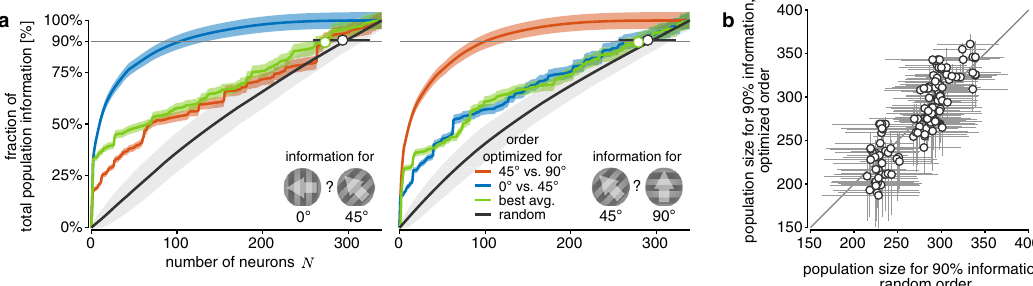
Fig. 5 No single neural subpopulation appears to encode a disproportionate amount of information across all stimulus drift directions. a Both panels show that the information increase in the recorded population depends on the order with which neurons are added to the population (colors). The panels differ in the considered drift direction discrimination (left: 0° vs. 45°; right: 45° vs. 90°). The neuron order was optimized by incrementally adding the neuron that resulted in the largest information increase for a 0° vs. 45° (blue) or 45° vs. 90° (orange) drift direction discrimination, or largest average increase across all discriminations with δθ = 45 ° (green). The optimal ordering for the 0° vs. 45° was also applied to the 45° vs. 90° discrimination (blue line in right panel) and vice versa (orange line in left panel). The average information increase across random orders (black) is shown as baseline reference. Shaded error regions illustrate the uncertainty (mean ± 1 SD) due to limited numbers of trials (all curves), and variability across random orderings (black only). The black and green open circle (bootstrapped median± 95% CI) show the population sizes required to capture 90% of the information in the recorded population for the associated orderings. b Plotting population sizes required to capture 90% of the information in the recorded population (bootstrapped median ± 95% CI) for random ordering vs. orderings optimized to maximize average information across all discriminations revealed no signi fi cant difference between the two orderings. Each dot re fl ects one discrimination for one